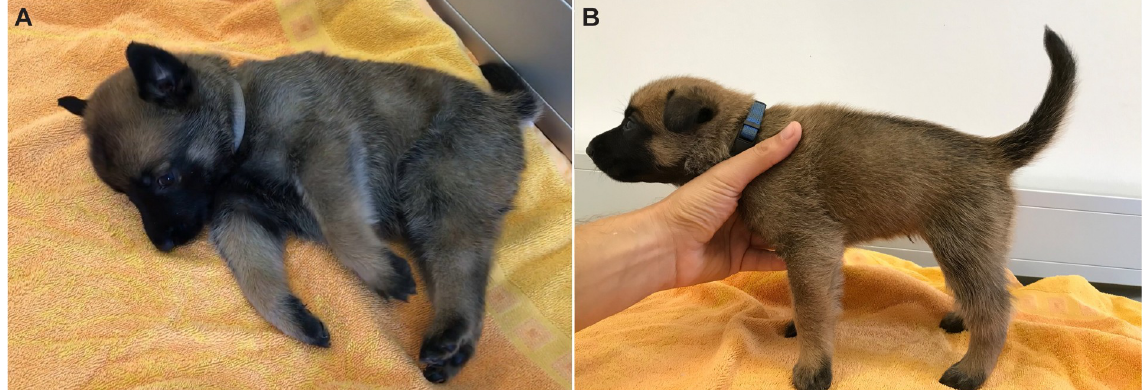
Fig 1. Clinical phenotype of the affected puppies. A Female affected puppy in lateral recumbency unable to stand up with severe tremor and episodic fits. B Male affected puppy with increased muscle tone of the trunk and neck as well as moderate tremor. More details of the clinical phenotype can be seen in the supplementary data (S1 Video and S2